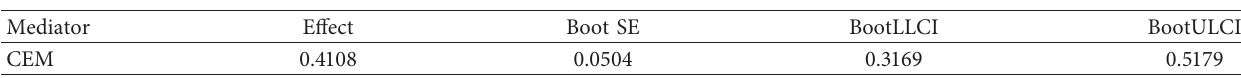
Table 5: The mediating effect of the consumption emotion between interface quality of mobile sales terminal and continual intention.